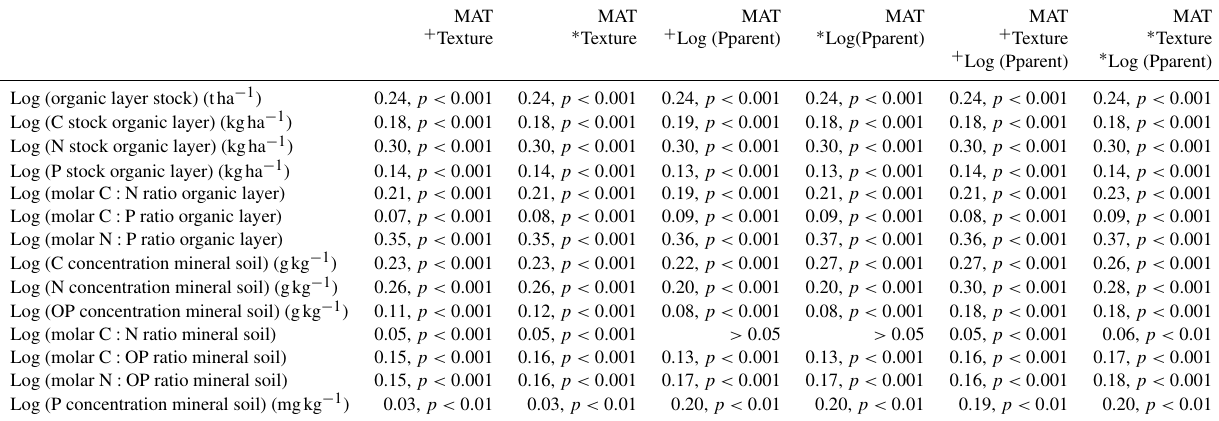
Table 2. Results of the multiple regression analyses (adjusted R 2 , p value) with ( ∗ ) and without ( + ) interactions of the independent variables for the organic layer and mineral soil (0–10cm) in 309 Swedish forest soils ( n = 309). Pparent stands for the P concentration of the parent material. MAT MAT MAT MAT MAT MAT +